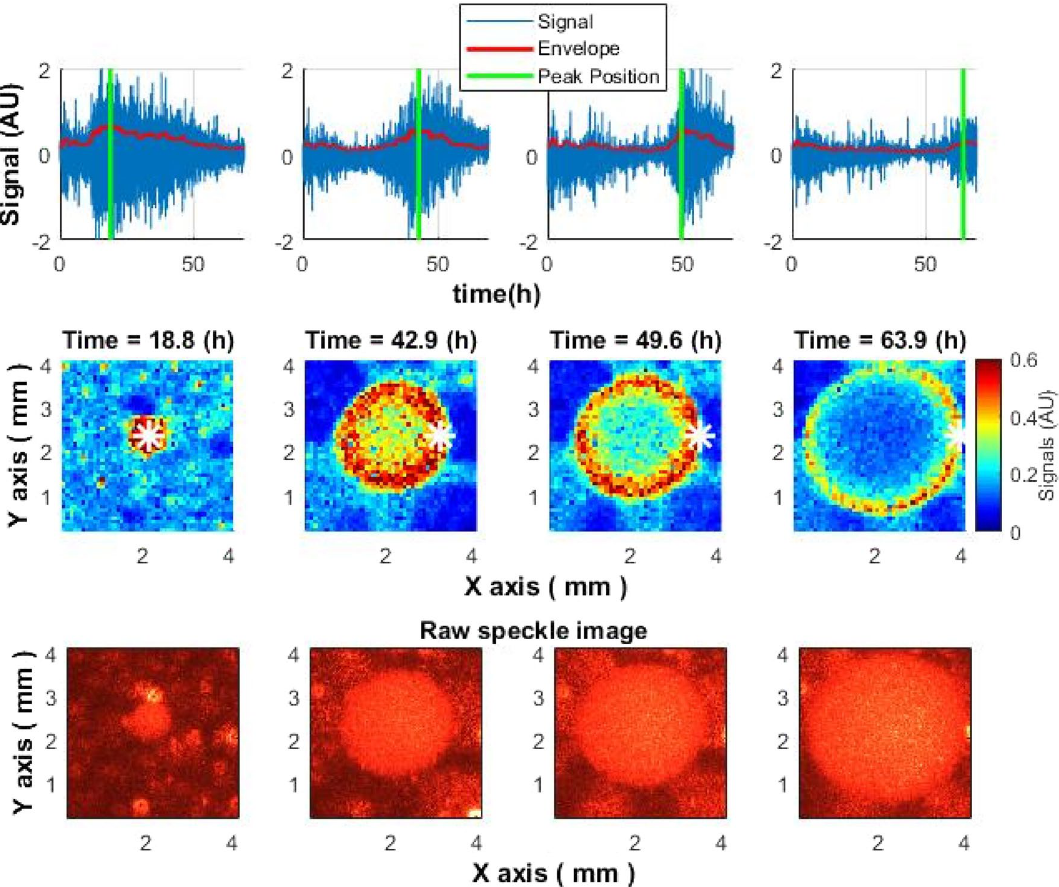
Figure 5. Spatiotemporal distribution of the speckle signal across S. aureus colony. Upper row: signal dynamics over time at different points within the colony (white star in the middle graphs). The green line marks the maximum activity, after which the signal decreases. Middle row: changes in the activity during colony growth. Bottom row: Raw speckle